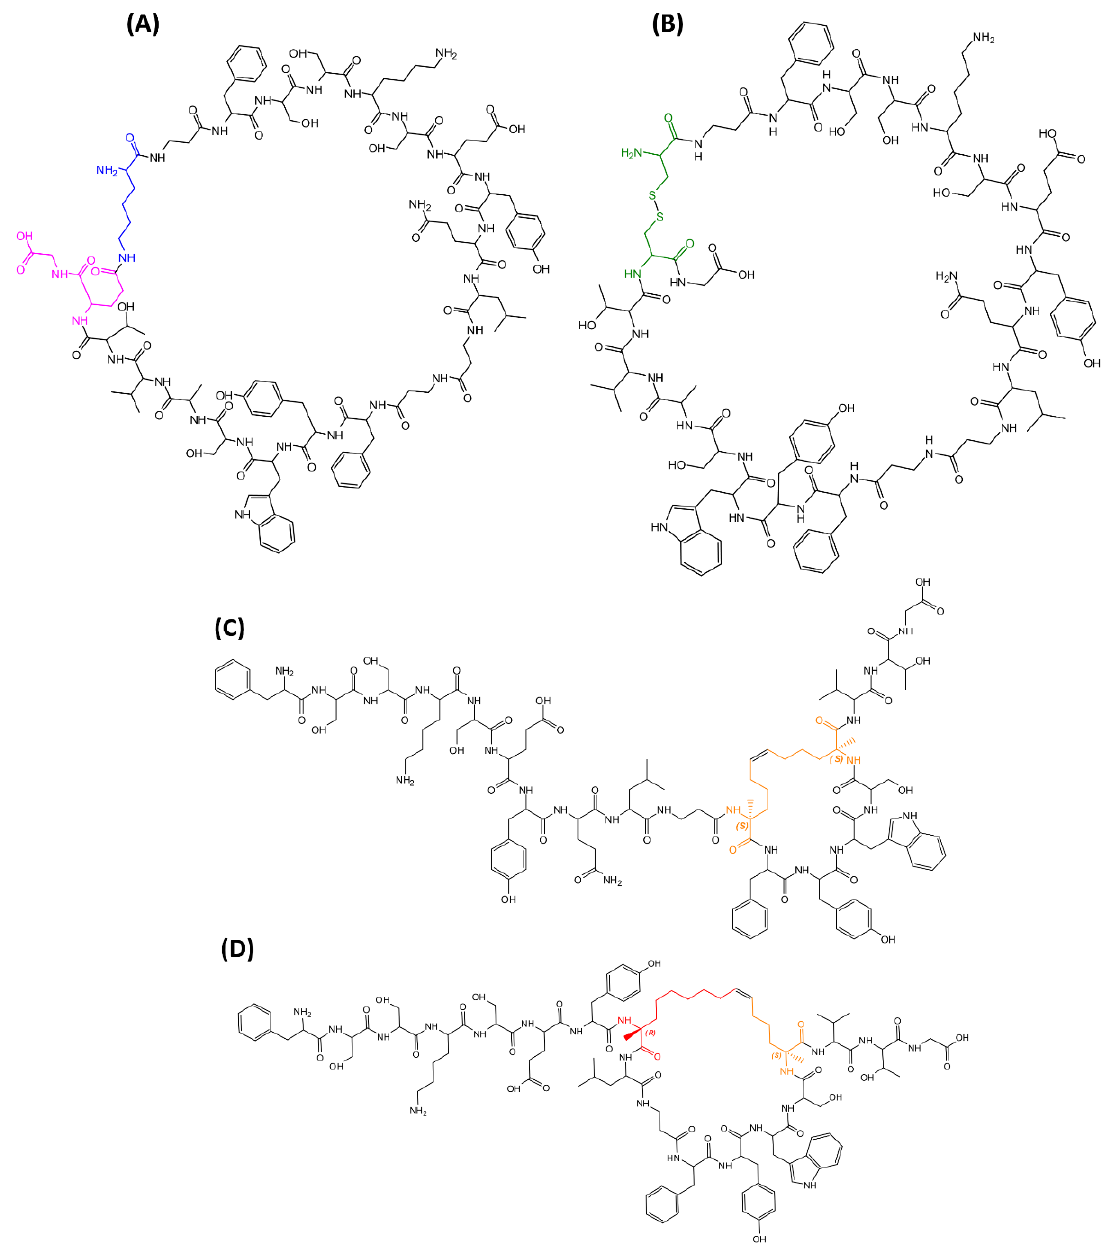
Figure 1. Chemical structures of KIRCONG analogues with residues involved in cycle formation colored: ( A ) KIRCONG amide (blue: Lys, purple: Asp), ( B ) KIRCONG disulfide (green: Cys), ( C ) KIRCONG i/i+5 (orange: (S)-N- 2-(4 (cid:48) -pentenyl) alanine) and ( D ) KIRCONG i/i+7 (orange: (S)-N-2-(4 (cid:48) -pentenyl) alanine, red: (R)-2-(7 (cid:48) -octenyl)